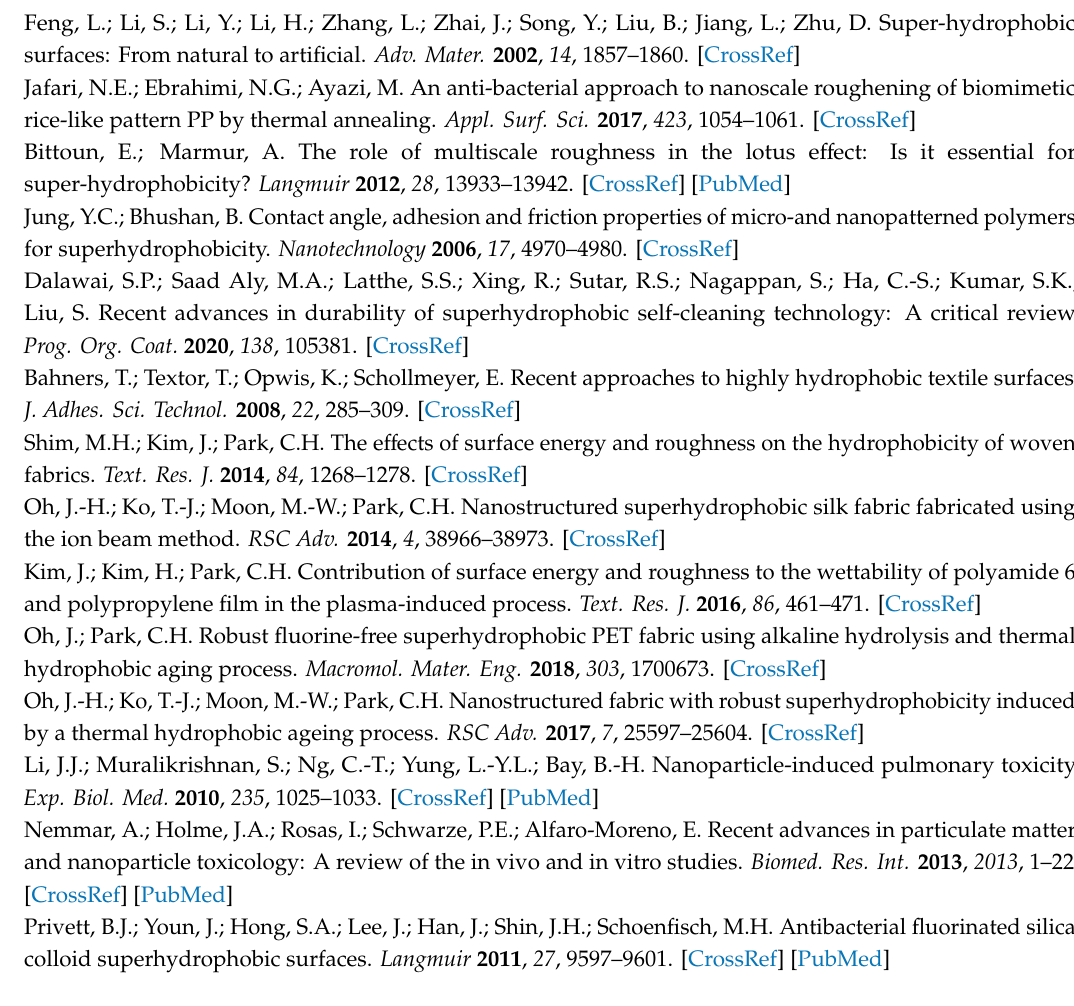
Figure S1: Characteristics of specimens according to weave density. Figure S2: SEM images of the plasma-etched specimens for 1, 3, 5, 7, 10, and 15 min. ( × 5000, top view). Figure S3: SEM images and nano roughness (AFM) of the plasma-etched for 5, 10, and 15 min. And thermal aging for 24 h. Figure S4: Photographs of water droplets on the specimens treated with plasma etching for 10 min and thermal aging for 24 h depending on various temperatures and time lapse. Figure S5: Degree of crystallinity of PP film (a) and PP fabric (b) and degree of orientation form XRD for PP film (c) and PP fabric (d). Figure S6: Kawabata surface roughness value of non-plasma etched specimen. Figure S7: A schematic of water droplets on the untreated PP fabric (a) and plasma-etched PP fabric for 15 min (b) having di ff erent weave densities. (left: 62 / inch × 62 / inch, center: 72 / inch × 72 / inch and right: 82 / inch × 80 / inch), Table S1. Glass transition temperature and melting temperature of PP fabric and PP film. Table S2. Water contact angle, shedding angle, and sliding angle of untreated PP fabric and PP film